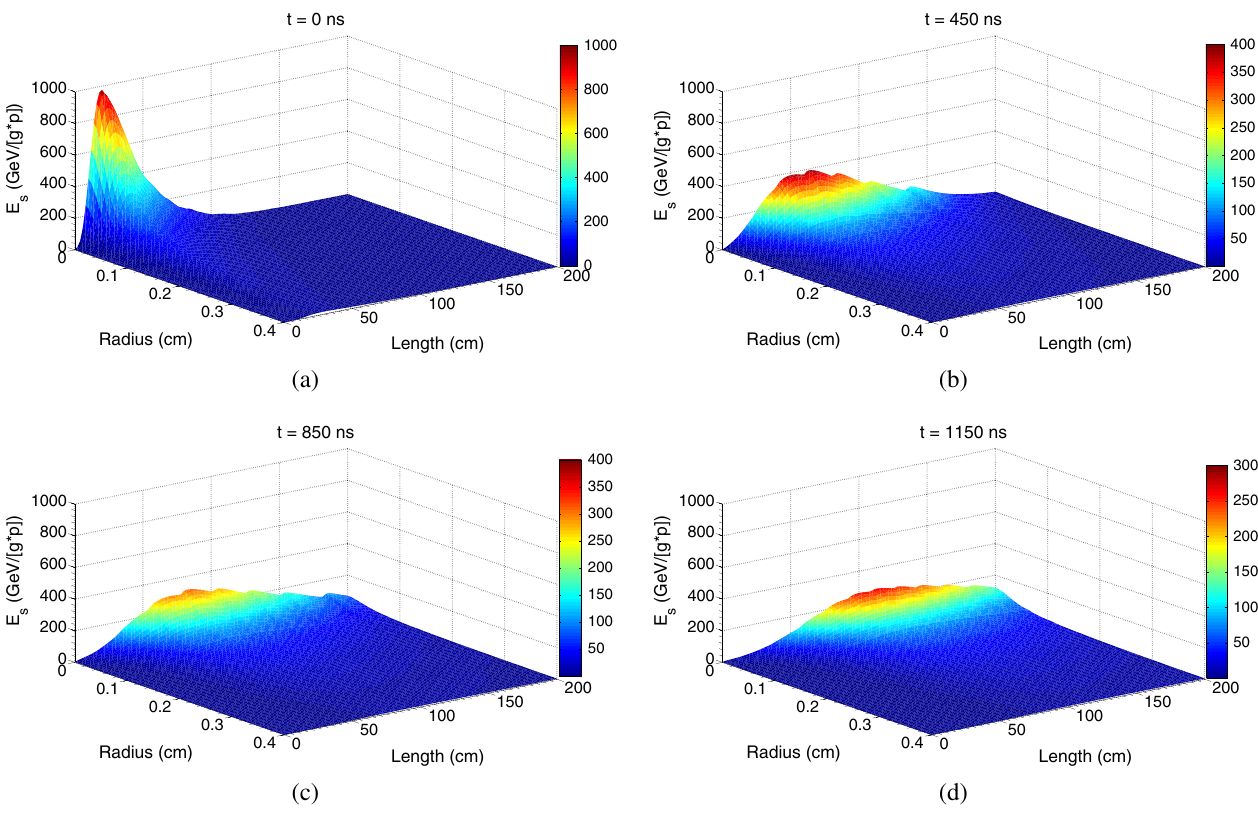
FIG. 1. Specific energy deposition E s for a 40 TeV FCC proton in a solid copper cylinder having radius r ¼ 2 cm, length L ¼ 500 cm, with facial irradiation, beam spot size characterized with standard deviation σ ¼ 0 . 2 mm using the FLUKA code (a) using a solid density of 8 . 93 g = cm 3 ; (b) using the density distribution provided by BIG 2 at t ¼ 450 ns, (c) using the density distribution provided by BIG 2 at t ¼ 850 ns, and (d) using the density distribution provided by BIG 2 at t ¼ 1150 ns ( FLUKA calculates energy deposition in the target by the beam with a defined spot size; the result is then downscaled for a single proton to allow an easy scaling depending on the total